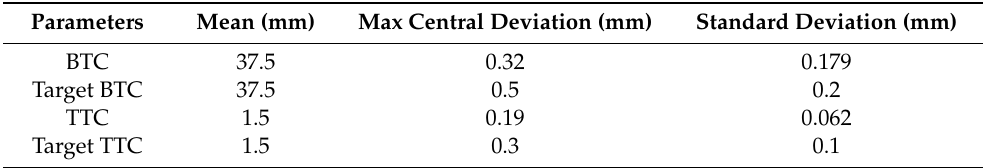
Table 3. The position of TTC and BTC.